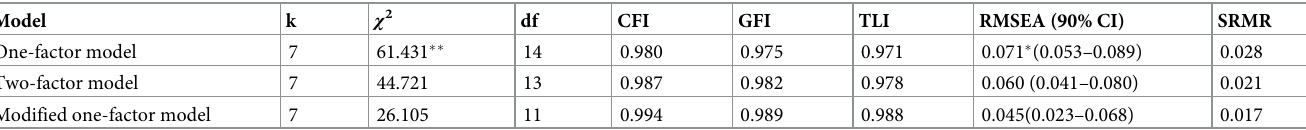
Table 3. Goodness of fit indices for the GAD-7 -item factor models ( n = 677).